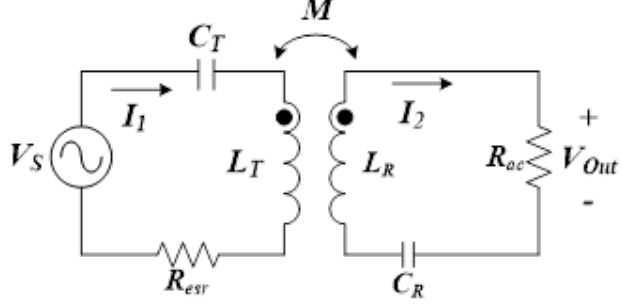
Figure 4. Equivalent circuit model in LC resonance operation.